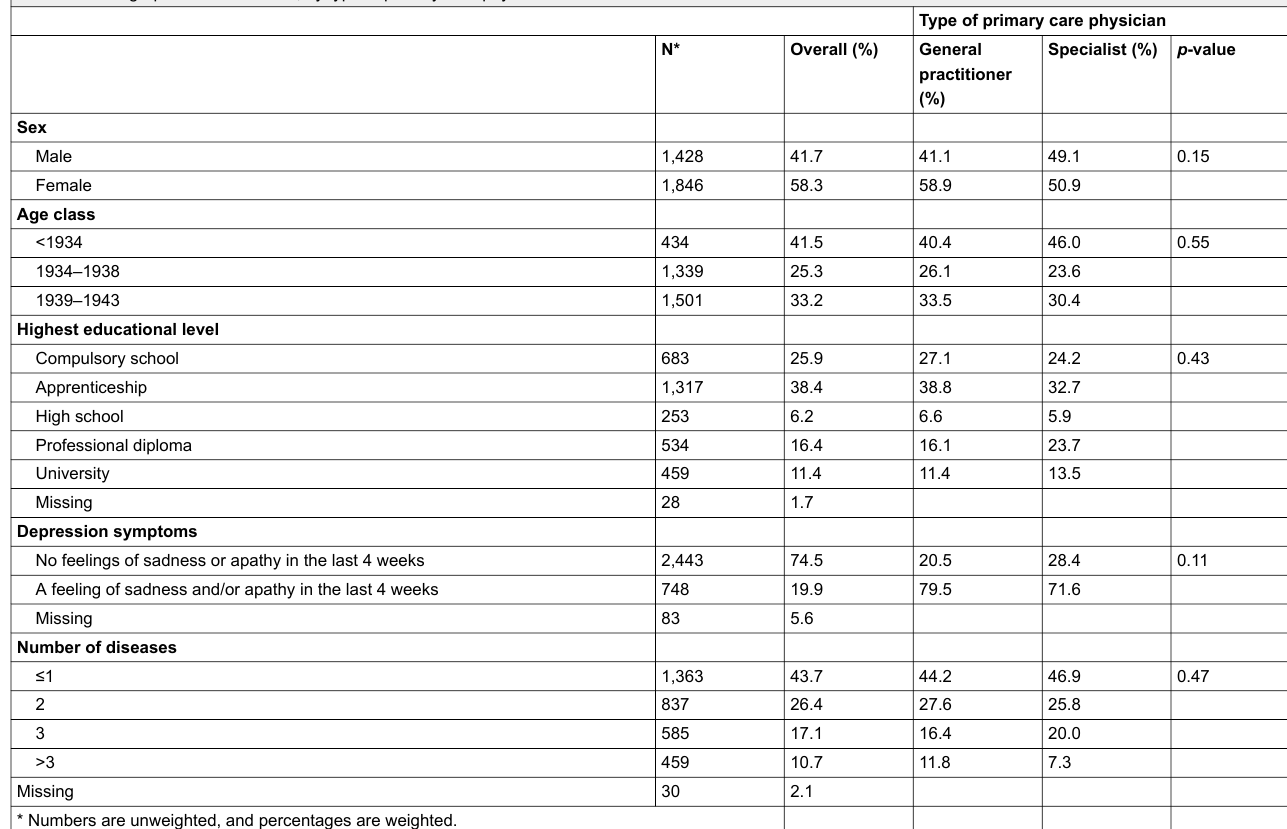
Table 1: Demographic characteristics, by type of primary care